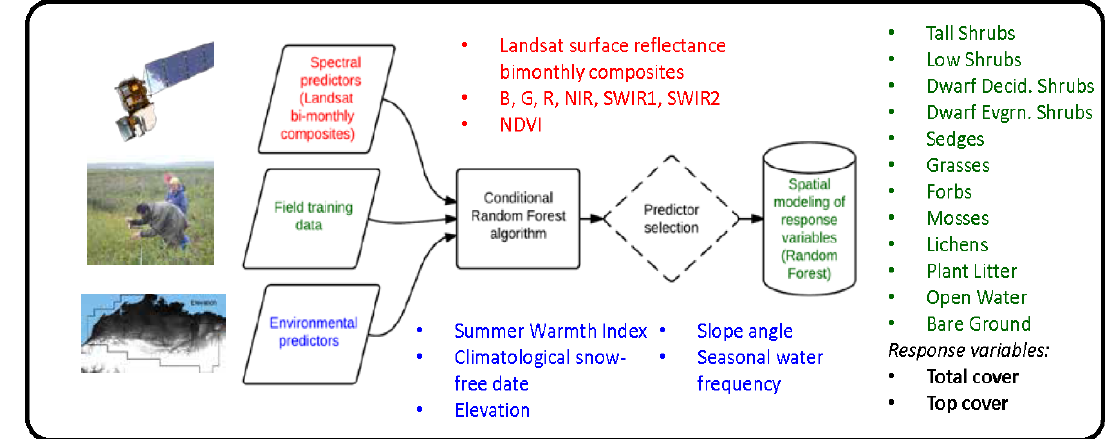
Figure 1. Map of quantitative-cover mapping area showing the distribution of field plots, North Slope, Alaska. ABR, ABR, Inc.—Environmental Research & Services. BLM, Bureau of Land Management.